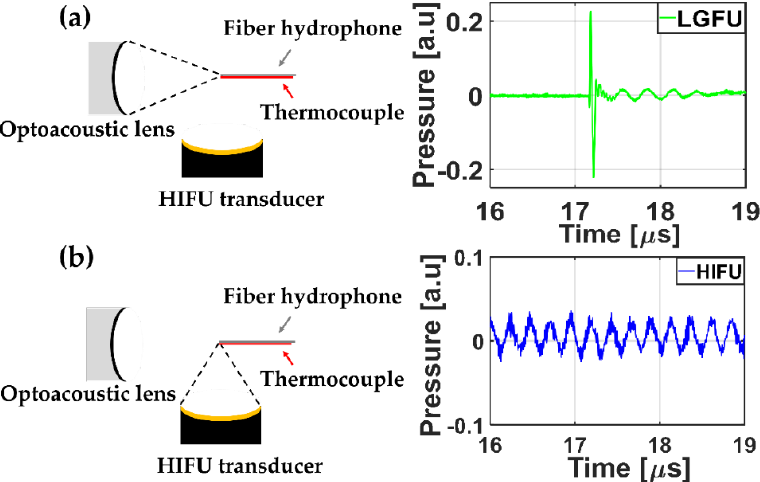
Figure 4. Temporal waveforms detected by a single-mode fiber-optic hydrophone when only the LGFU was turned on ( a ) and only when the HIFU was turned on ( b ).